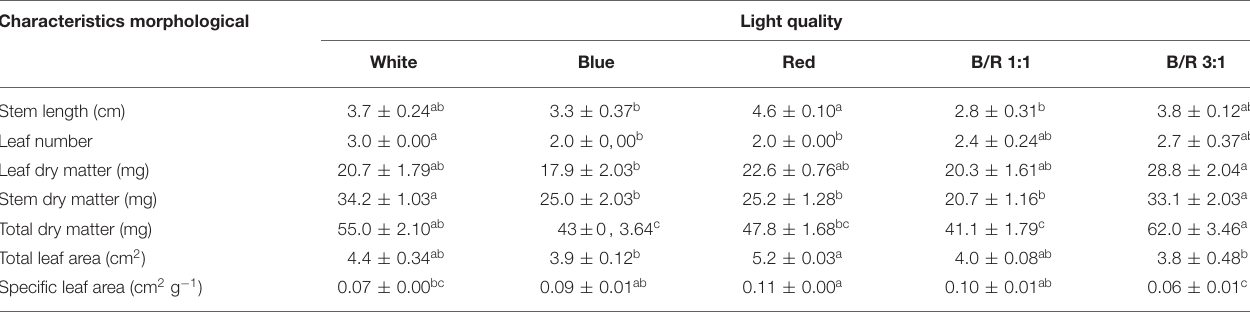
TABLE 2 | Growth parameters of Brosimum gaudichaudii seedlings grown in vitro under different LED spectra for 50 days. Characteristics